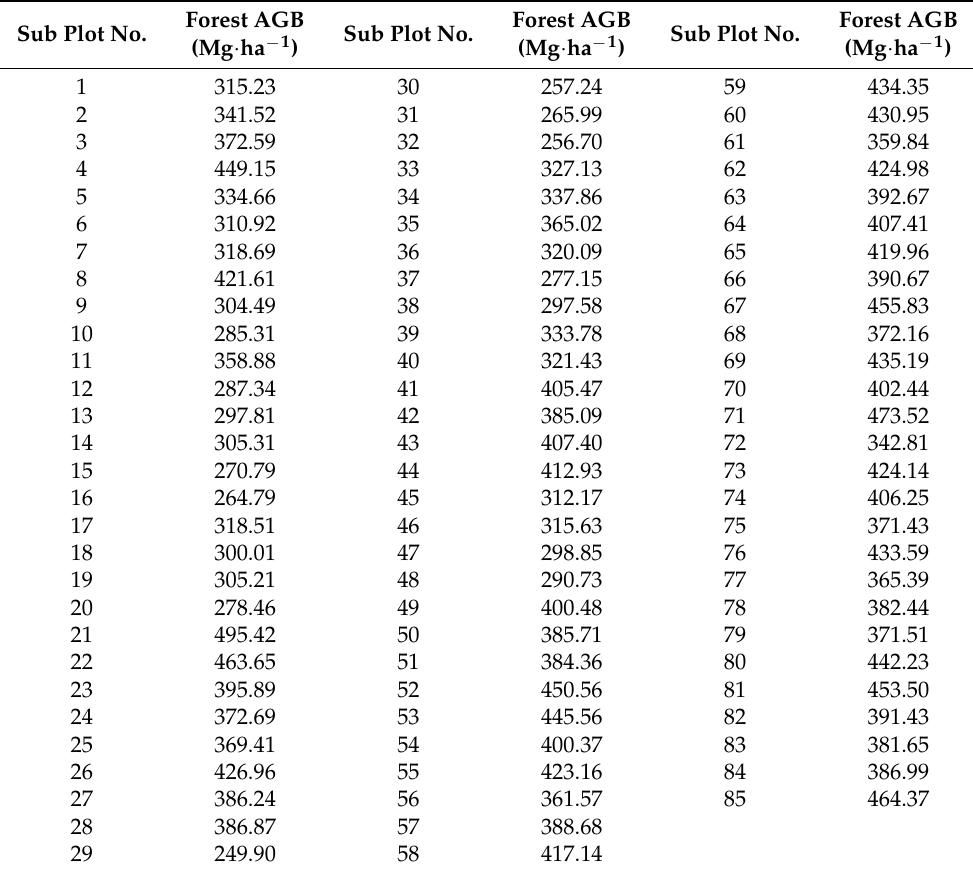
Table 2. Forest aboveground biomass (AGB) data of sub sample plots. Sub Plot